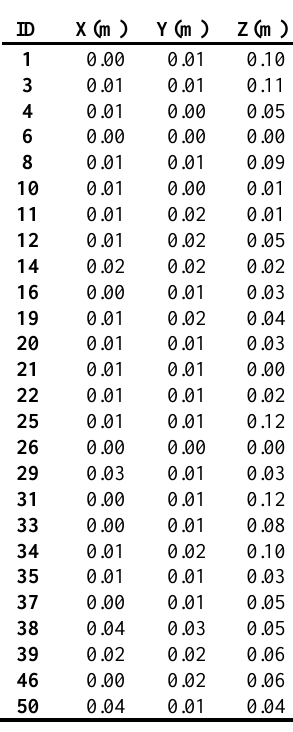
Table 2. Accuracy check on 26 CPs when testing the GCPs method. X, Y and Z indicate the error along the homonymous direction. The accuracy check on CPs along the Z direction for the method of GCSs is reported in Figure 10 Figure 10. As in the previous case, errors along X and Y directions are negligible, but they are reported in Table 3 together with those along the Z